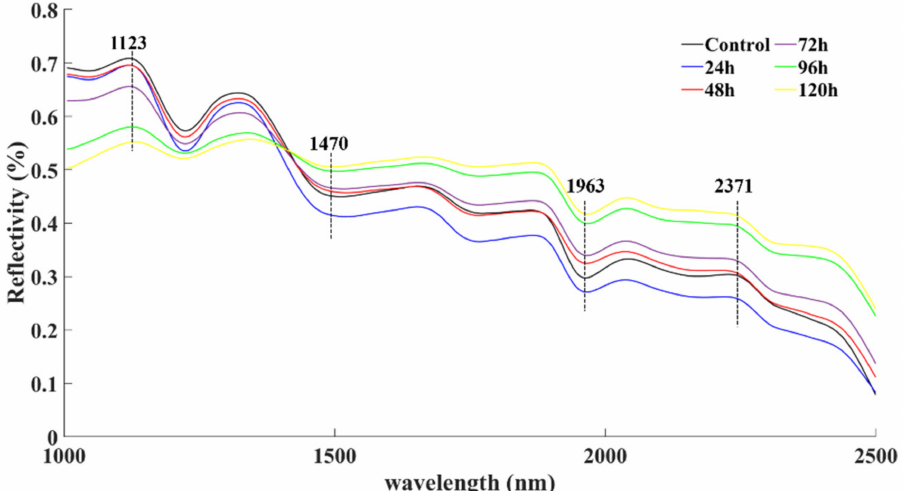
Figure 2. Mean spectral data of peanut kernels inoculated with A. flavus .